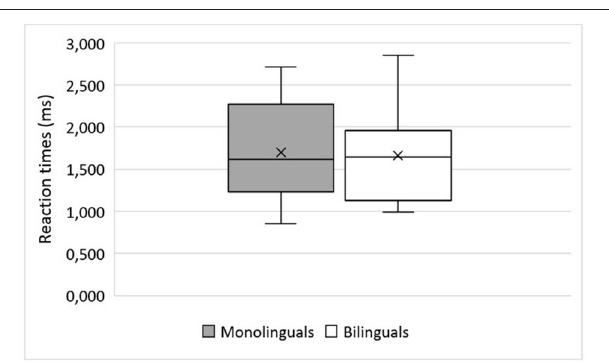
FIGURE 3 | Reaction times after hearing the onset of the first object in the sentence-picture matching task in monolingual and bilingual speakers. x = mean (mean monolinguals = 1,700ms, SD = 0,561ms; mean bilinguals = 1,663ms, SD =